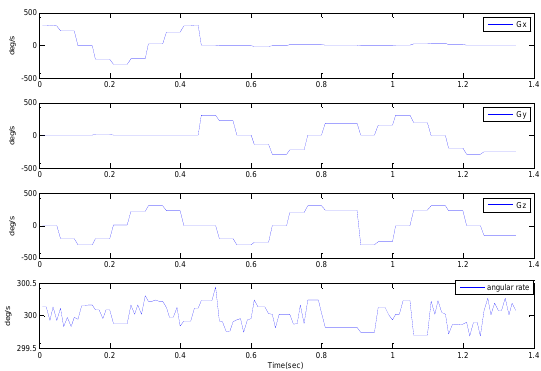
Figure 6. The calibration results of the gyroscope